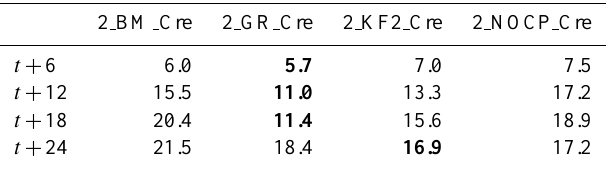
Table 13. Mean Absolute Error (MAE) (mm) for the 9 Novem- ber